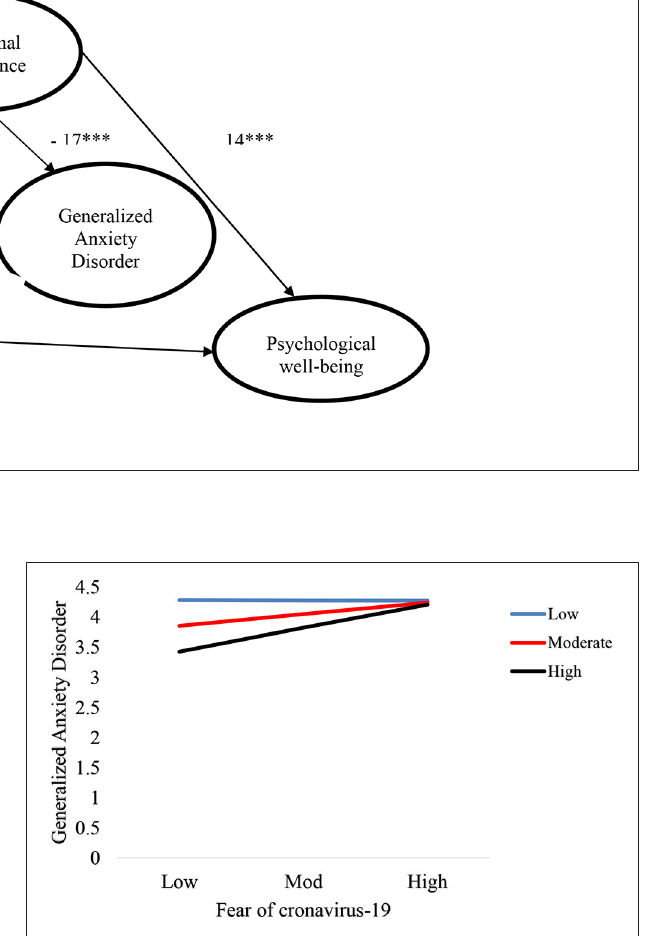
FIGURE 3 | Interaction plot of the fear of COVID-19 and emotional intelligence on Generalized Anxiety Disorder.